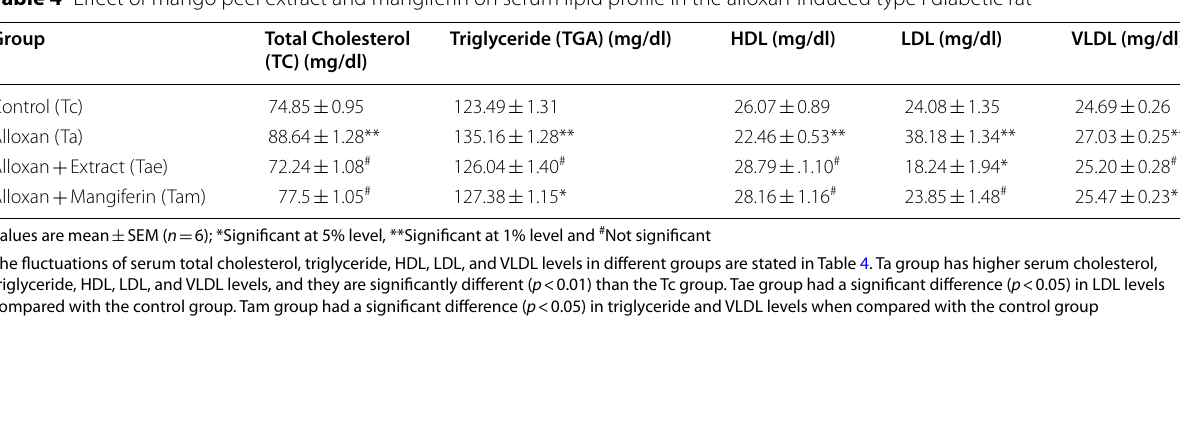
Table 4 Effect of mango peel extract and mangiferin on serum lipid profile in the alloxan-induced type I diabetic rat